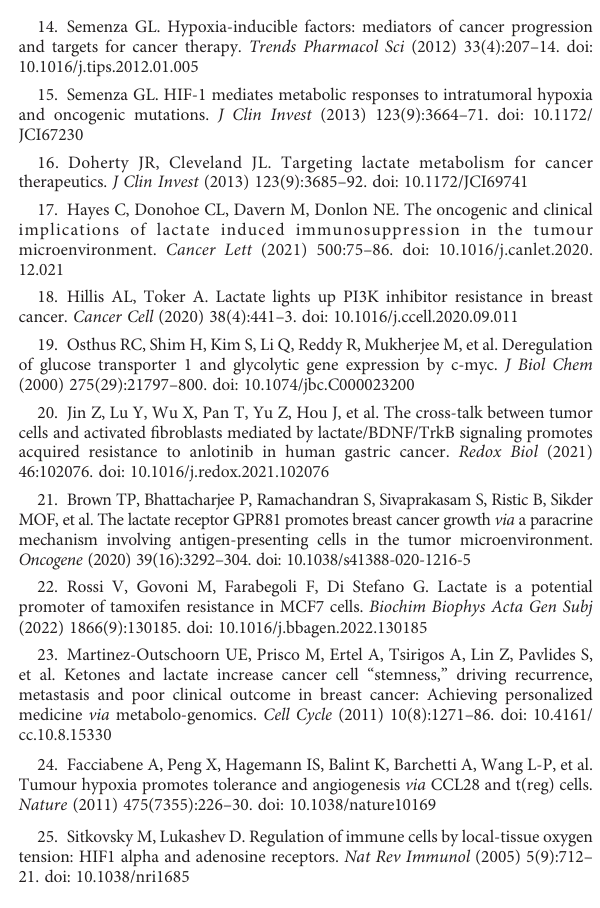
SUPPLEMENTARY FIGURE 1 The immunohistochemistry staining characteristics of the fi ve HLRPGsfrom the HPA database. SUPPLEMENTARY FIGURE 2 The heatmap showed the correlation between fi ve HLMRGs expressionsand the critical cancer signaling pathways. SUPPLEMENTARY TABLE 2 A total of 284 lactate-related genes and 493-hypoxia related genes usedin this